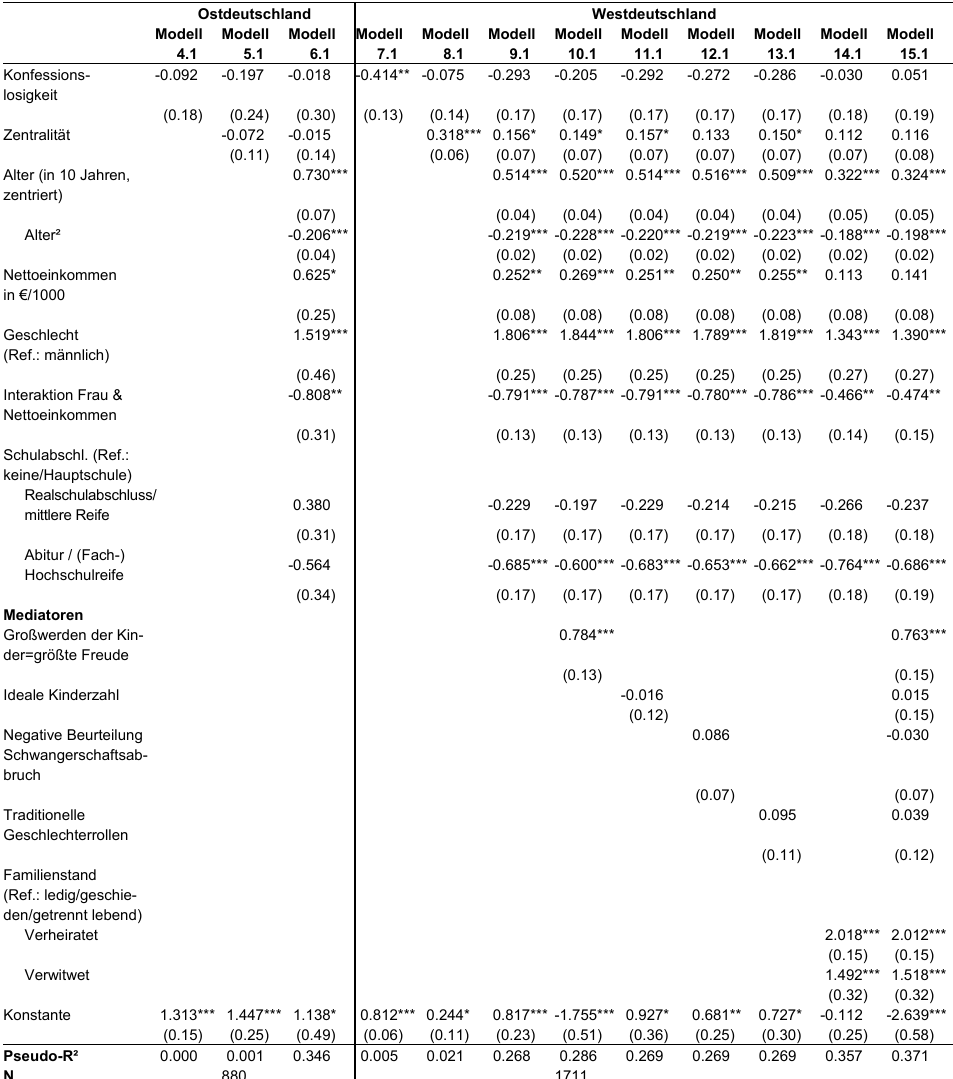
Tabelle 2 : Zentralität und Elternschaft: Mediationsanalyse (Poisson-logit-Hurdle- Regressionen, 1. Gleichung Logit) Ostdeutschland Westdeutschland